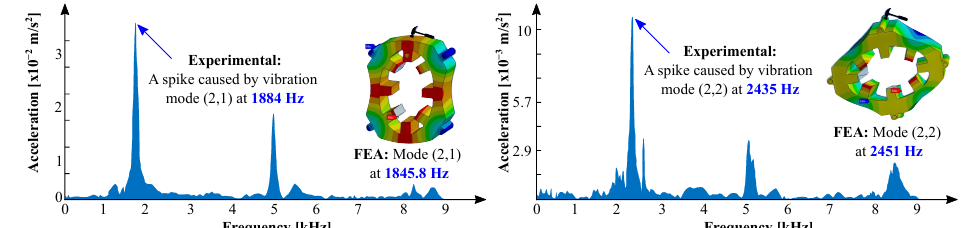
Figure 8. Impact hammer test frequency domain and FEA calculated results for vibration modes (2,1) and (2,2) [57–60]. Table 1. Comparison of SPL measured experimentally and calculated from the multiphysics toolchain. Experimental